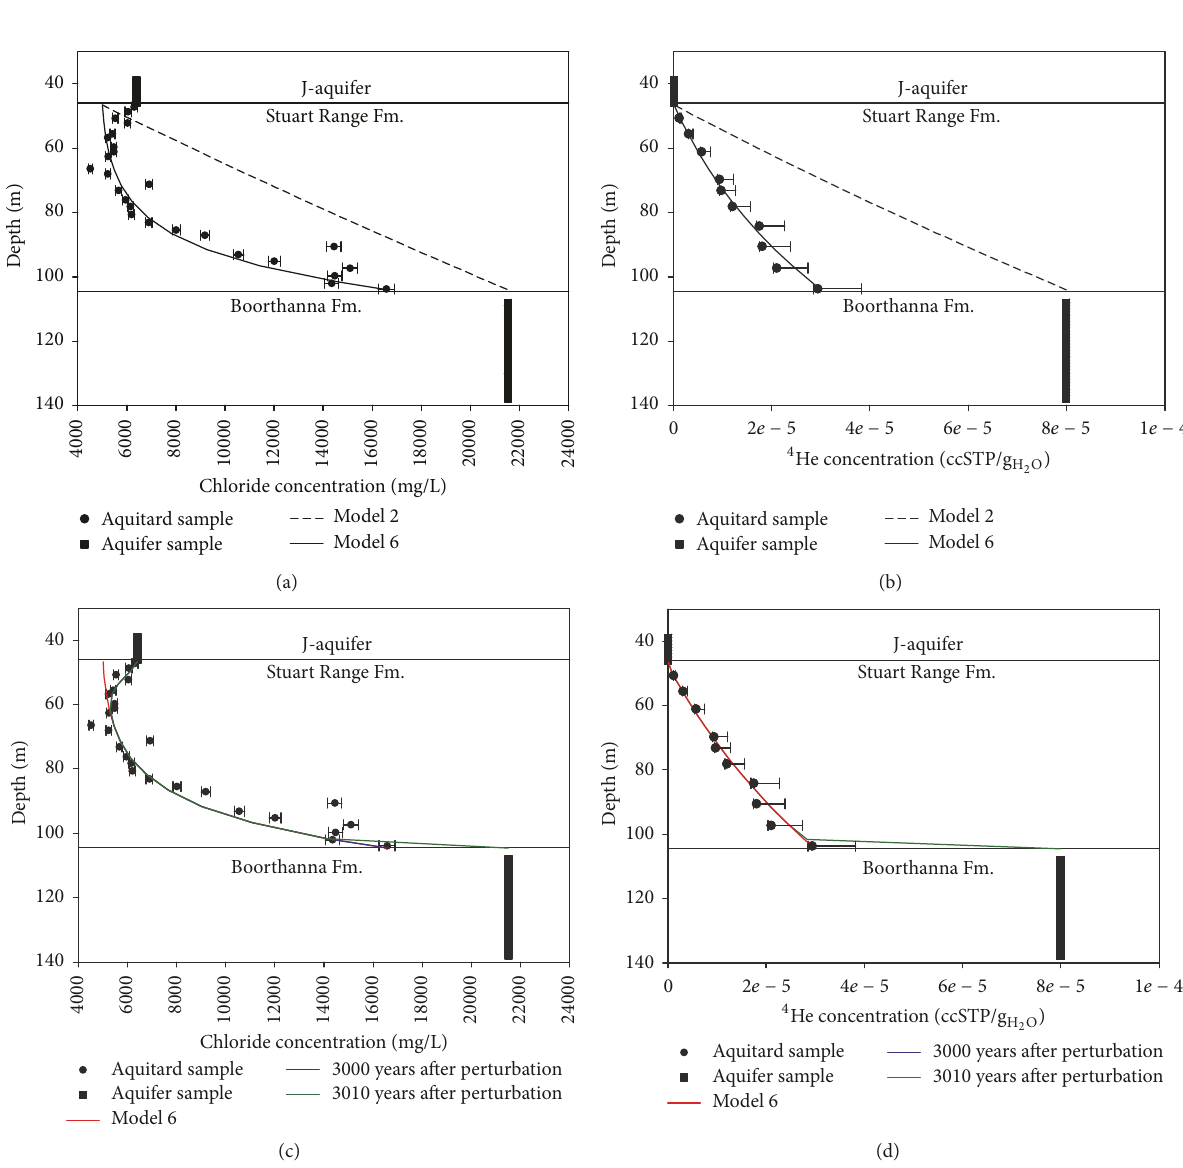
Figure 6: Steady state solute transport model 6 represented as a solid line compared to steady state solute transport analytical model 2 represented as a dashed line for (a) chloride and (b) 4 He concentration. The chloride concentration was then increased in the upper aquifer and then subsequently the helium and chloride concentrations were increased in the lower aquifer in model 7 giving the modelled profile for (c) chloride and (d) 4 He